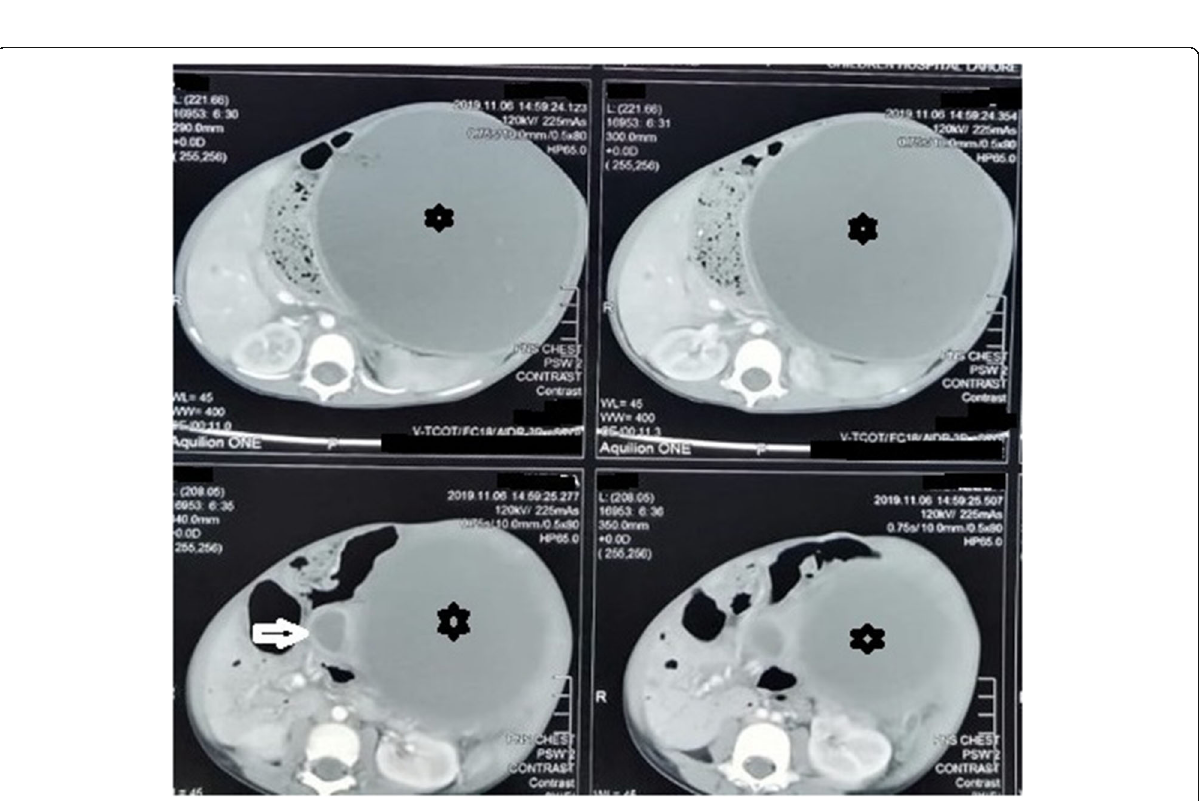
Fig. 2 Showing a huge cystic collection in the abdomen (*). Note a hypodense area in relation to stomach representing gastric duplication cyst (white